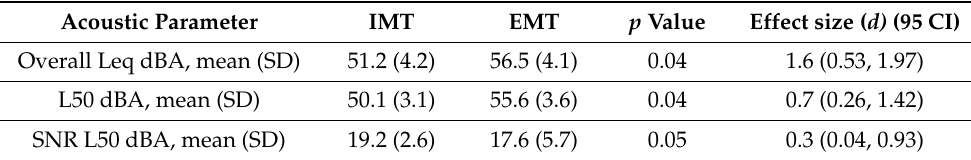
Table 3. Open room acoustic data for IMT and